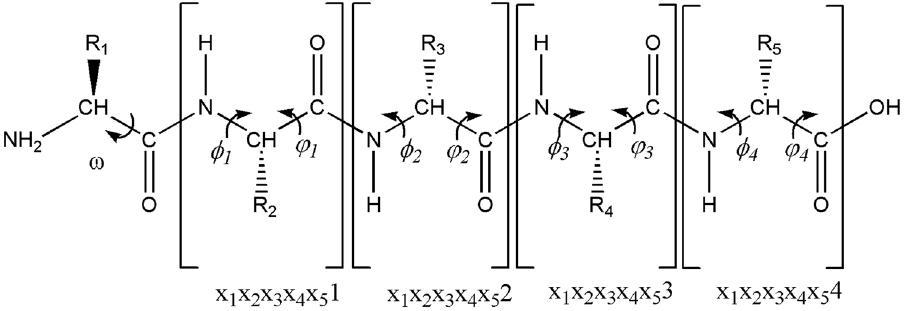
Figure 1. The ϕ - ψ units in a pentapeptide X 1 X 2 X 3 X 4 X 5 . Generally, x 1 x 2 … x n i refers to the ϕ - ψ unit of the ( i + 1) th AA residue in a peptide X 1 X 2 … X n with n AA